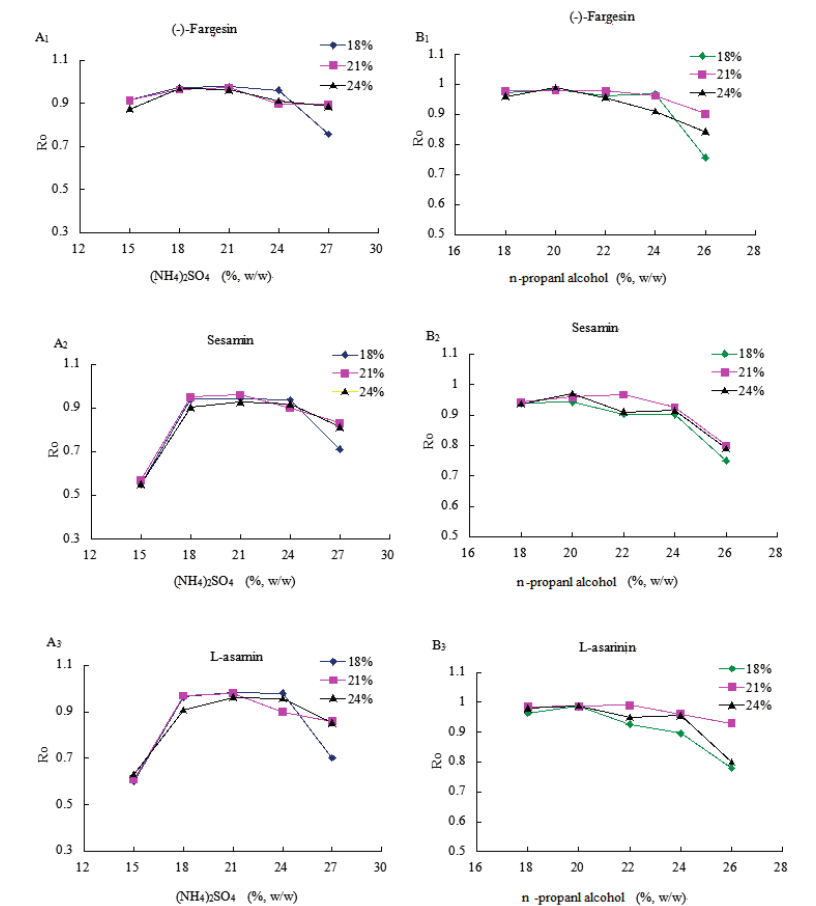
Figure 4. Effect of (NH 4 ) 2 SO 4 ( A ) / n- propanol ( B ) concentrations on the recovery ( R 0 ) of three lignans (1: Far; 2: Ses; 3: